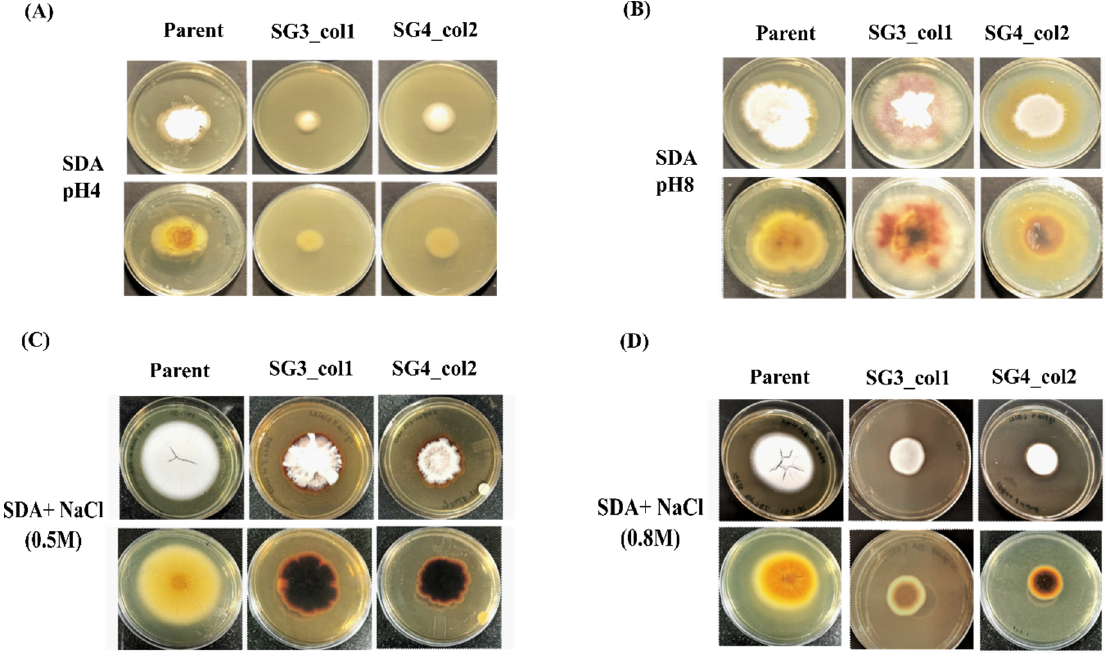
Figure 5. The growth of pacC mutants as a function of pH variation and saline stress. The growth of selected pacC mutants (SG3_col1 and SG4_col2) was monitored on ( A ) buffered SDA plates at acidic pH (pH 4.0), ( B ) buffered SDA plates at alkaline pH (pH 8.0), ( C ) SDA plates supplemented with 0.5 M NaCl, and ( D ) SDA plates supplemented with 0.8 M NaCl. The top and bottom panels are images of front and reverse sides of the agar plates, respectively. The growth of the parent T. rubrum IGIB-SBL-CI1 strain is also shown as a reference